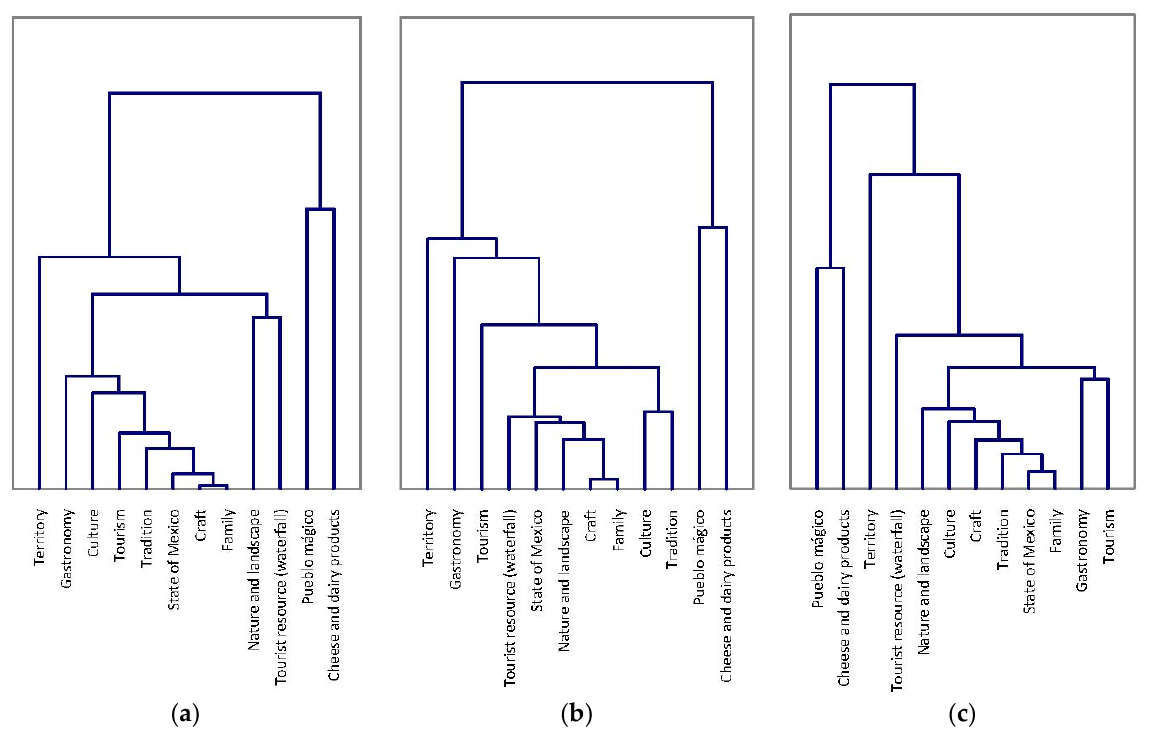
Figure 2. Cluster analysis based on distance matrices from the three study samples. ( a ) Survey with ballot papers. ( b ) Online survey. ( c ) Random sample.